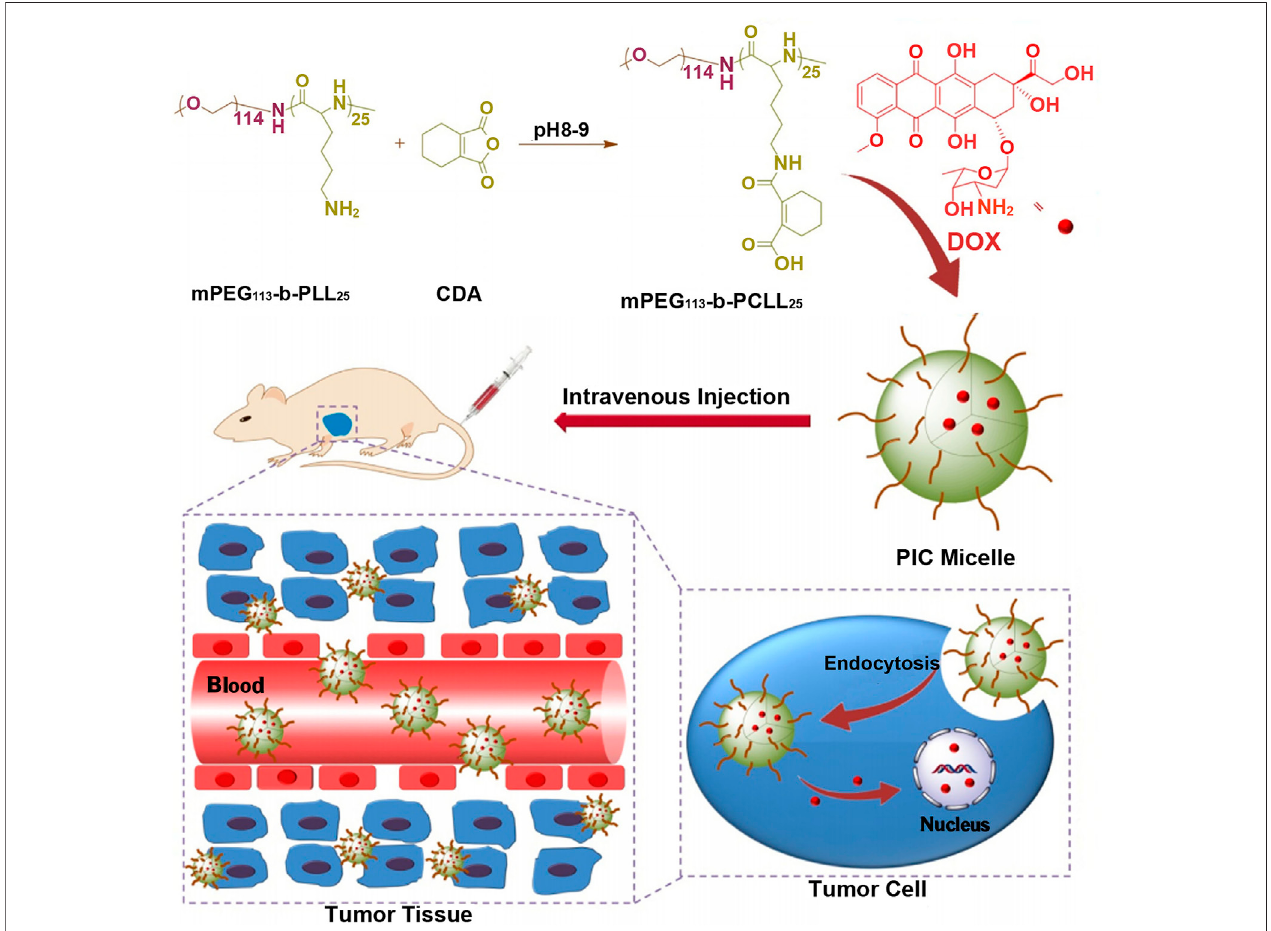
FIGURE5| Schematic illustration ofthepreparationofpH-responsive PIC micelle,andits circulation invivo ,accumulation intumor tissue,and fi nally,pH-triggered intracellular DOX release after intravenous injection (Wang J. et al., 2015). Abbreviation: PEG, poly(ethylene glycol); PLL, poly(L-lysine); CDA, cis-cyclohexene-1,2- dicarboxylic anhydride; PCLL, poly(N( ε )-((1-carboxy-cis-cyclohexene)-2-carbonyl)-L-lysine; DOX, doxorubicin; PIC micelle, polyion complex micelle.